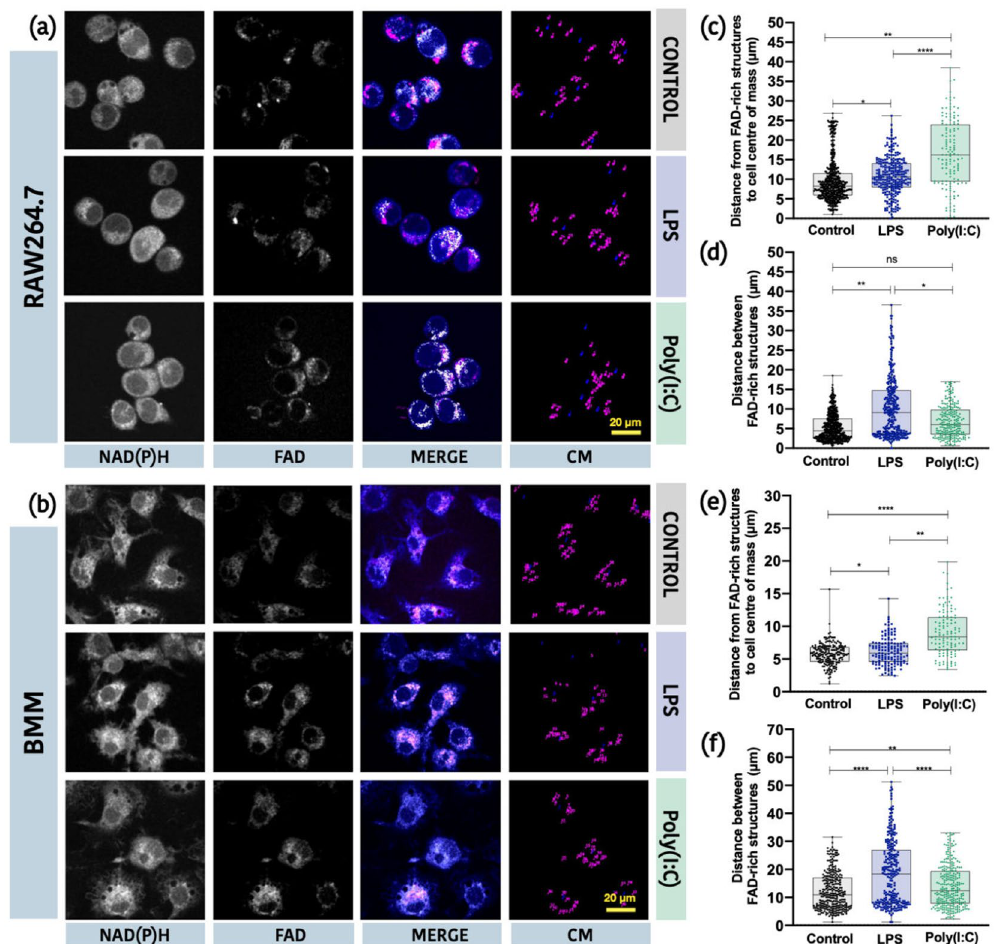
Figure 6. FAD-TPEF intensity localization is a potential marker for mitochondrial organization. Representative images of ( a ) RAW264.7 cells and ( b ) primary BMM, showing from left to right, NAD(P)H-TPEF intensity, FAD-TPEF intensity, Merged TPEF intensity from NAD(P)H and FAD channels, and the centre of mass (CM) distribution of FAD-rich structures. Distance of FAD-rich structures to cell centre of mass for RAW264.7 cells ( c ) and primary BMM ( e ). Distance between FAD-rich structures for RAW264.7 cells ( d ) and primary BMM ( f ) (*p < 0.05, **p < 0.01, ***p < 0.001, ****p < 0.0001, ns: